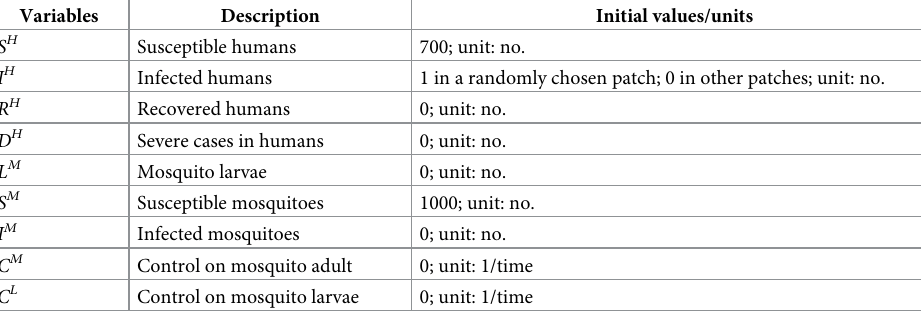
Table 1. All variables and the corresponding initial values in patch j.